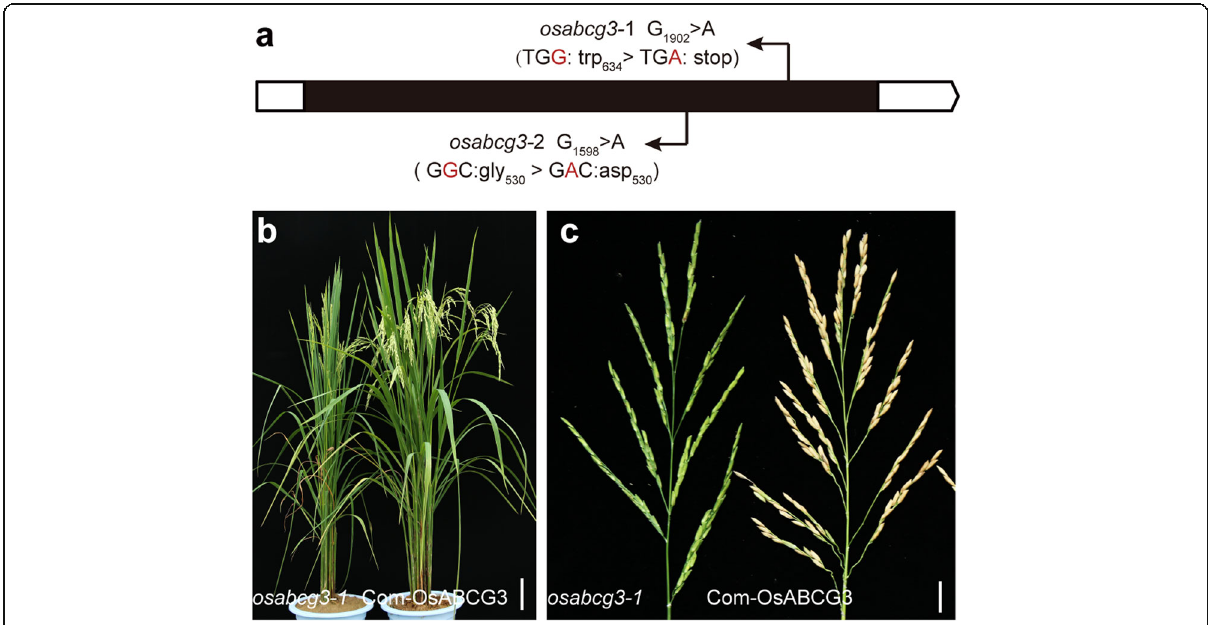
Fig. 2 Identification and complementation of OsABCG3 . a The gene structure of OsABCG3. Mutations of OsABCG3 in osabcg3 – 1 and osabcg3 – 2 were showed. Black box indicates exon, and white box indicates UTRs. b, c Transgenic complementation of the osabcg3 – 1 mutant. Plants ( b ) and seed set ( c ) of osabcg3 – 1 and transgenic osabcg3 – 1 mutant complemented with the OsABCG3 fragment were showed. Scale bars=10 cm ( b ) and 1 cm ( c